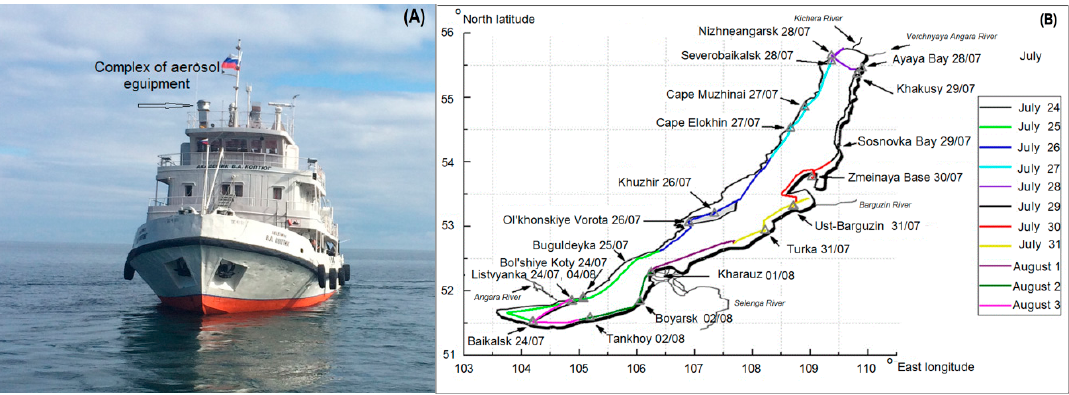
Figure 1. The research vessel (RV) «Akademik V.A. Koptyug» ( A ) and scheme of the RV route ( B ), sites of the main stops.